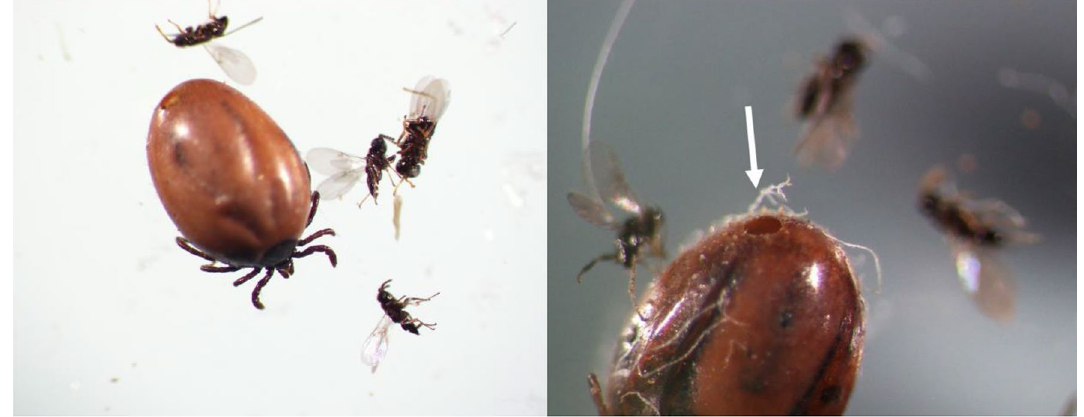
Figure 2. Ixodes ricinus nymph with endoparasitoid wasps Ixodiphagus hookeri (the arrow indicates the aperture in the tick cuticle through which the I. hookeri specimens